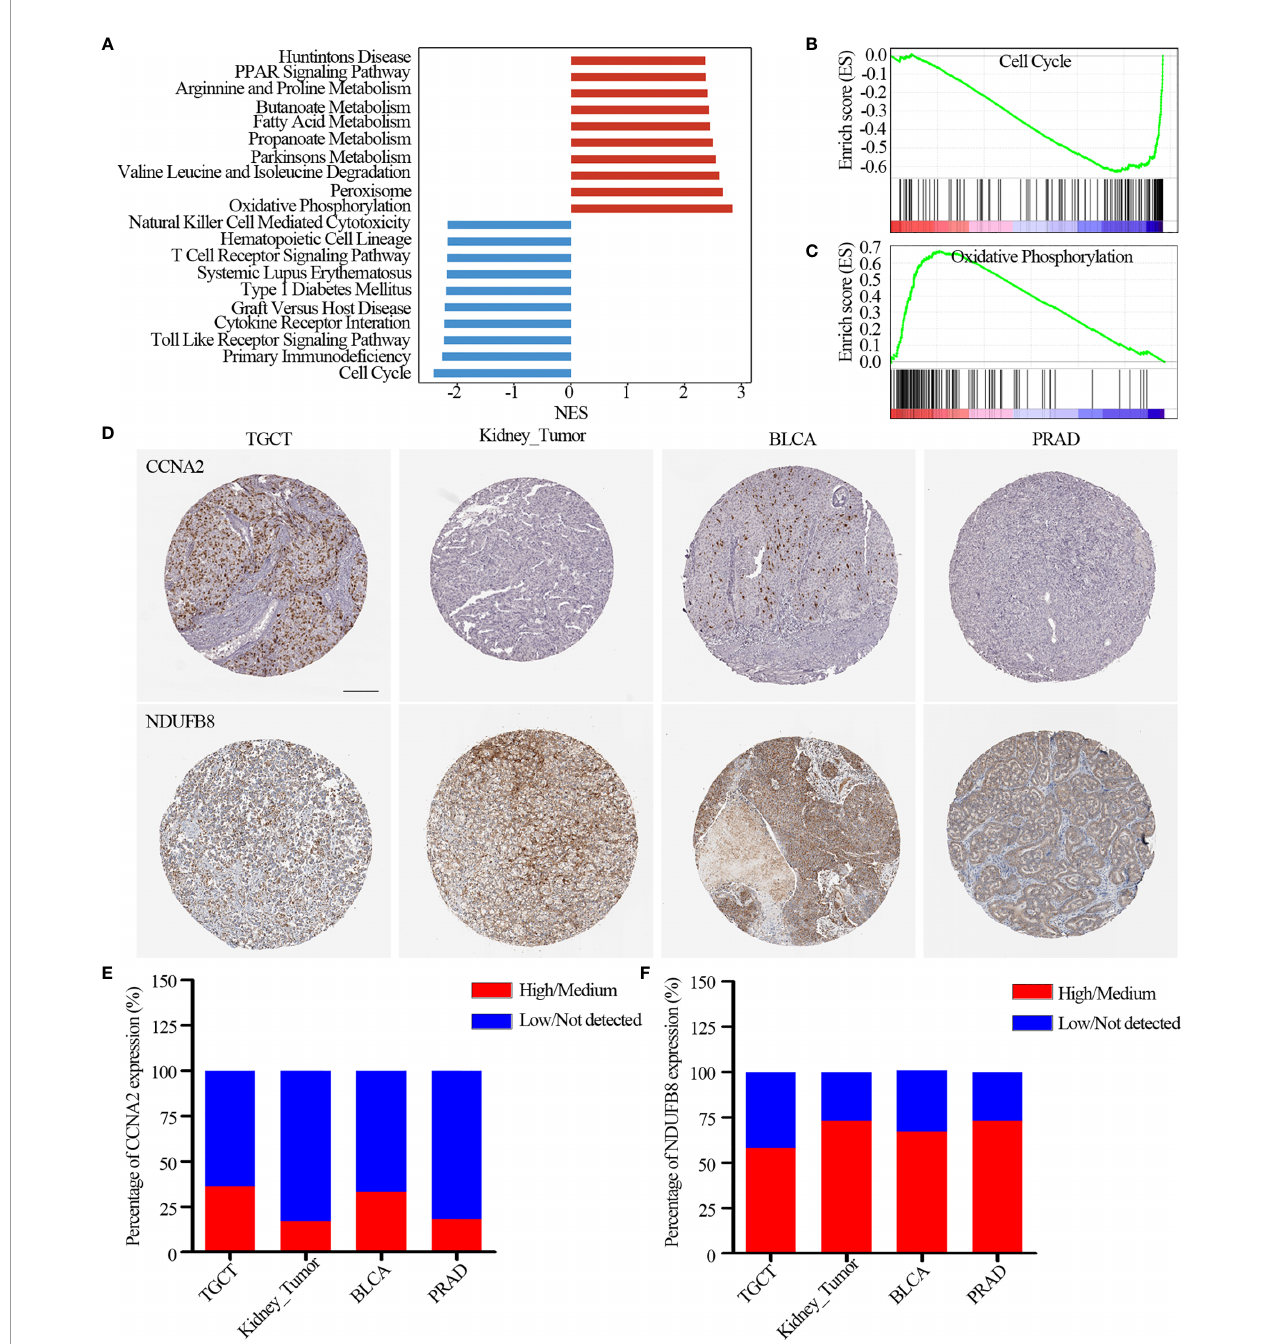
FIGURE 6 | Pathways potentially regulated by HDAC11. (A) Distribution of normalized enrichment scores for pathways. The pathways colored in blue was the depleted pathways in HDAC11 downregulation, while the red one is enriched pathway. (B, C) GSEA-enrichment plot of the representative gene sets. (B) Cell cycle; (C) Oxidative phosphorylation. (D) Immunohistochemistry images of CCNA2 and NDUFB8 in TGCT, kidney_tumor, BLCA and PRAD. Scar bar = 200um. (E, F) Protein expression percentage of CCNA2 (E) and NDUFB8 (F) analyzed by